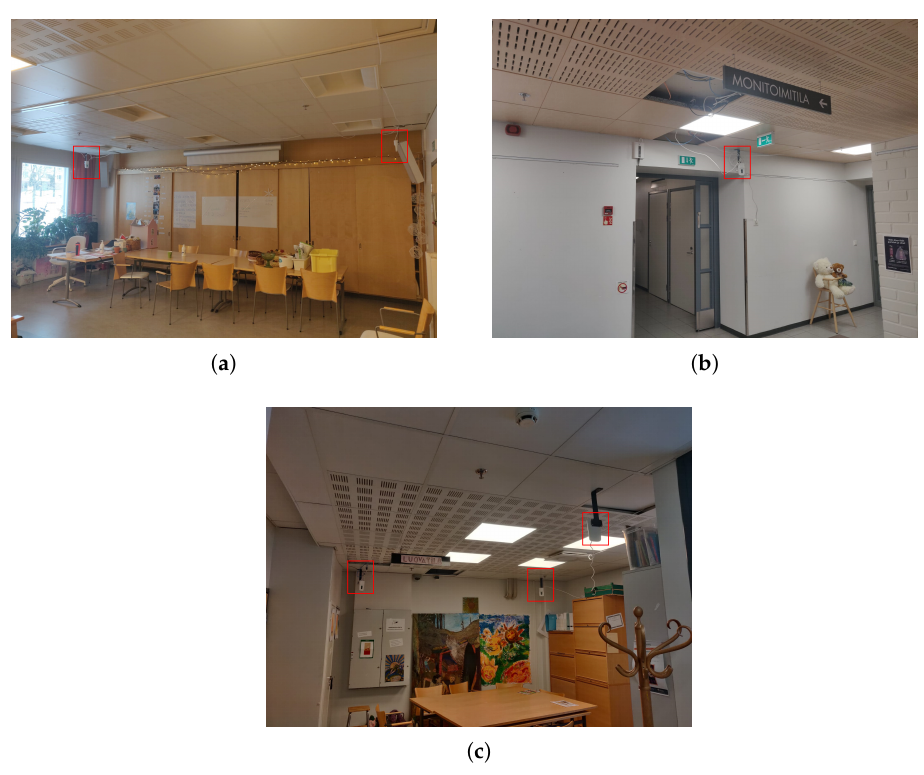
Figure 3. Anchors physically mounted in the elder care premises. ( a ) Activity Center; ( b ) Gymnasium; ( c ) Arts and craft